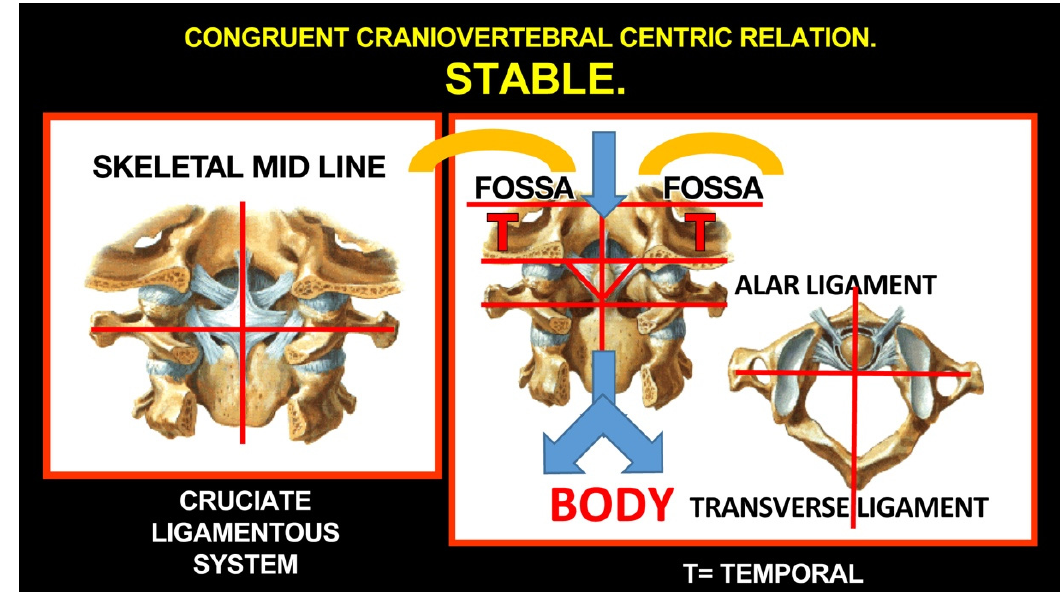
Figure 30. Stable, centric relation of the craniovertebral joints.